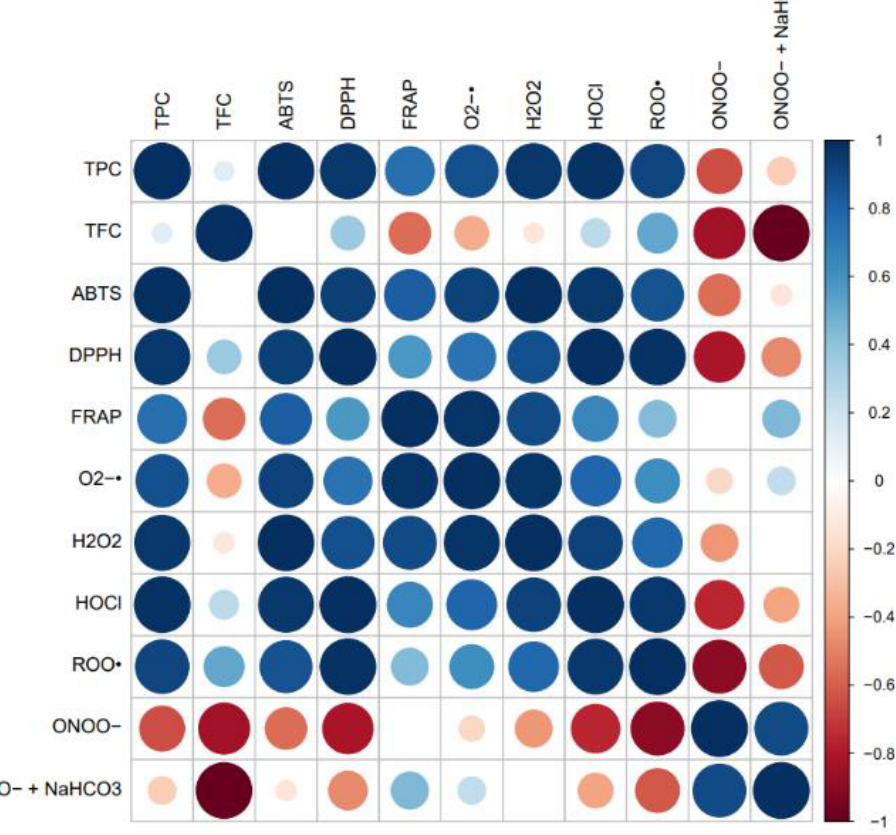
Figure 3. Correlation heatmap between TPC, TFC, antioxidant, and antiradical activity results for functional cookies enriched with chestnut shells extract evaluated by a color diagram.